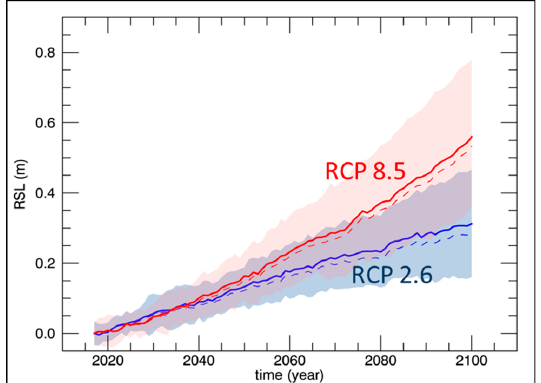
Figure 17. Graph of the sea-level rise projection estimated at the upper 95% bounds of the regional Intergovernmental Panel on Climate Change (IPCC) sea-level projections, integrated with the contribution of the mean Vertical Land Movements (VLM) rate derived from the cGPS data and long-term geological elevation of the MIS 5.5 marine terrace, relative to 2019 AD. Upper and lower curves refer to the RCP 8.5 and RCP 2.6 climate scenarios, respectively. The small scale sea-level variations are related to the modeled sea-level variability due to the ocean component contribution accounting for the effects of dynamic Sea Surface Height (SSH), the global thermosteric SSH anomaly, and the inverse barometer effects ([23,24]; http://icdc.cen.unihamburg.de/ [71]).